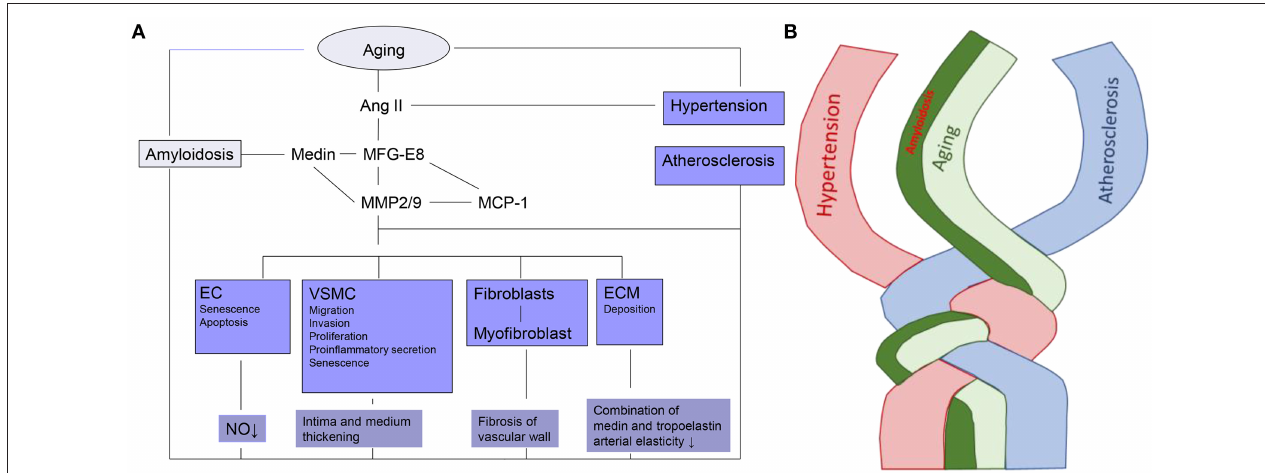
FIGURE 1 | The linkage and twist of VA with aging. (A) Cellular and molecular mechanisms of VA. Ec, endothelial cell; VSMC, vascular smooth muscle cell; ECM, extracellular matrix; Ang II, Angiotensin II; MFG-E8, Milk fat globule-epidermal growth factor-8; MMP2/9-zinc, containing endopeptidases2/9; MCP-1, Monocyte chemoattractant protein-1; NO, Nitric oxide. (B) Amyloidosis is intertwined with arterial aging, hypertension and